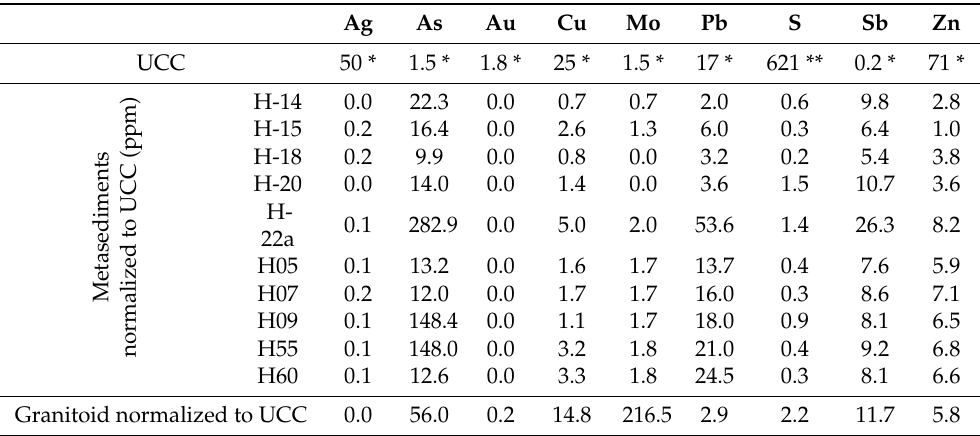
Table 5. Upper continental crust (UCC)–normalized elements of metasediments in Sakarkaya Forma- tion and Düztarla granitoid